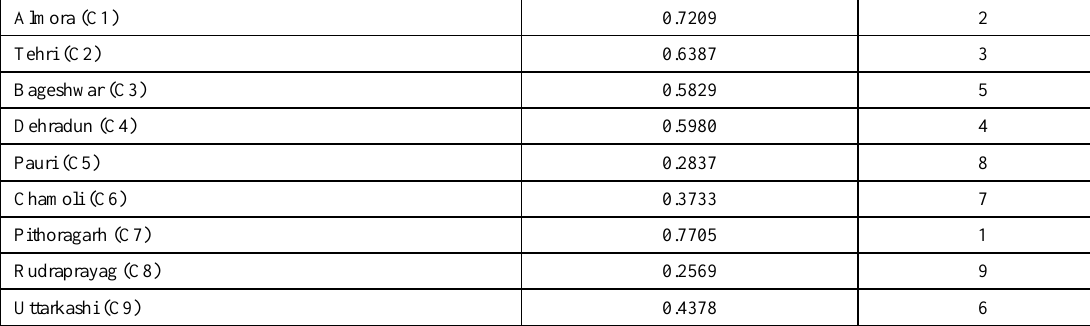
Table 8. Relative closeness (RC) of an alternative to the ideal solution& ranking of clusters Almora